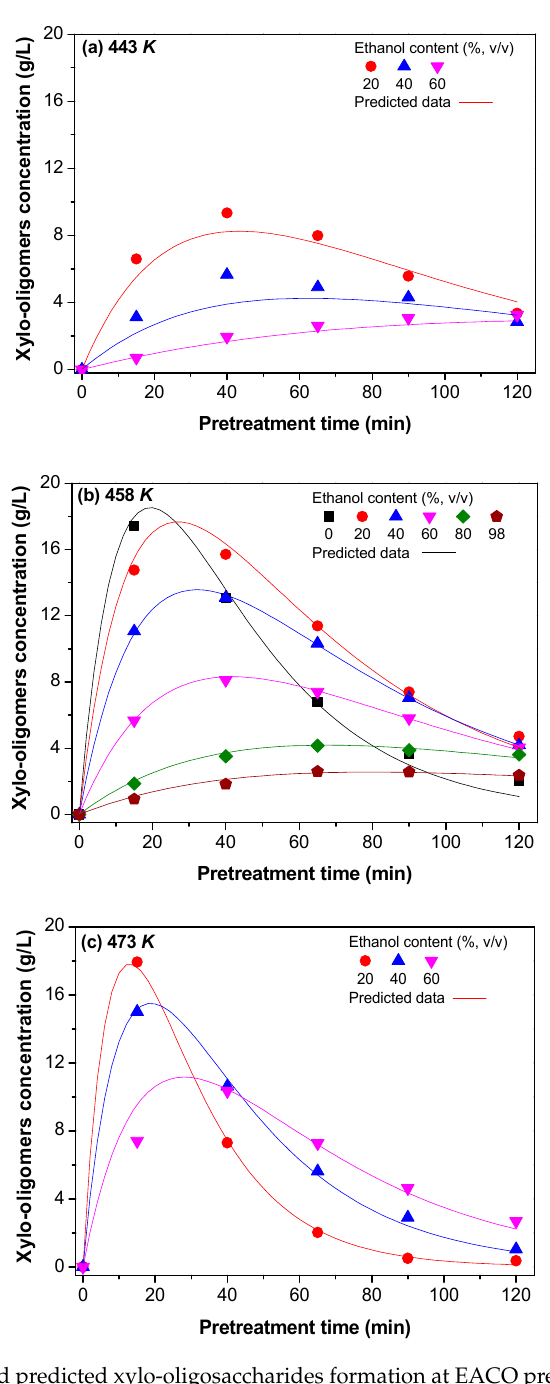
Figure 2. Measured and predicted xylo-oligosaccharides formation at EACO pretreatment temperature of ( a ) 443, ( b ) 458 and ( c ) 473 K with different ethanol content (%, v/v) in pretreatment liquor.